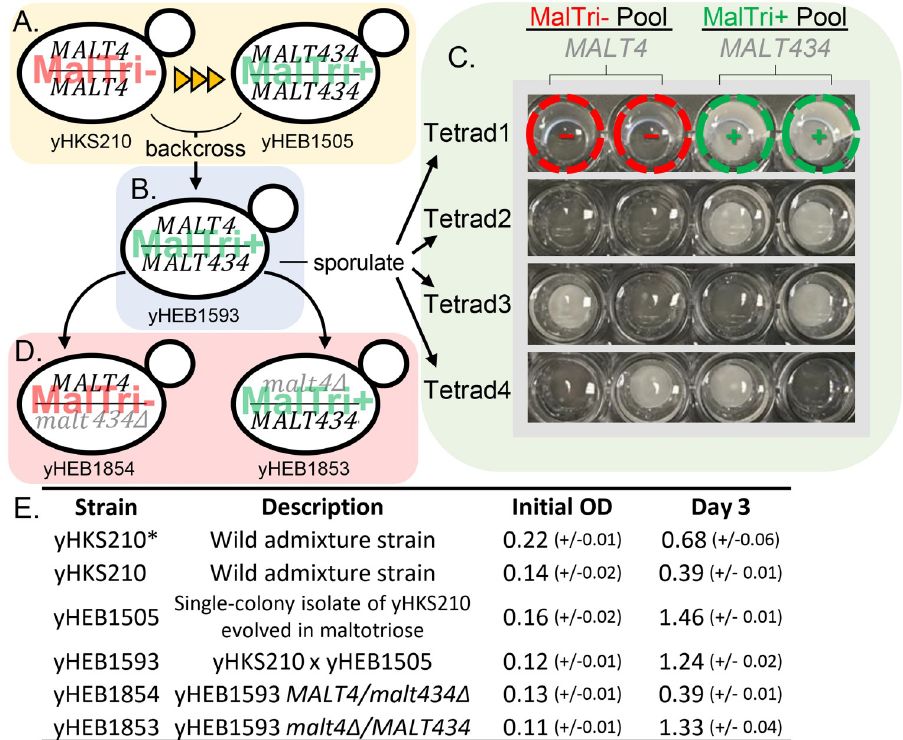
Fig 3. Evolution and validation of the chimeric maltotriose transporter Malt434. A) After continuous culturing on maltotriose with a small amount of added glucose, WI- Seub (yHKS210), which was originally unable to use maltotriose (MalTri-), evolved the ability to consume maltotriose (MalTri+). B) Strain yHEB1593, which is a backcross between yHKS210 and yHEB1505, was also MalTri+. C) To test the inheritance of maltotriose utilization, yHEB1593 was sporulated. The panel shows a subset of tetrads screened growing on SC + 2% maltotriose. Examples of MalTri- spores in Tetrad 1 are circled in red, and MalTri+ examples are circled in green. Whole genome sequencing of MalTri+ and MalTri- pools showed that maltotriose utilization perfectly correlated with the presence/absence of MALT434 . D) Reciprocal hemizygosity test [81] of the MALT4/MALT434 locus in the backcross strain yHEB1593. E) Table of initial and day-three OD 600 (OD) readings of yHKS210, yHEB1505, yHEB1593, yHEB1853, and yHEB1854 on SC + 2% maltotriose as the sole carbon source. N = 3, standard deviation in parentheses. � Control grown in SC + 0.04% glucose to reflect the approximate amount of growth expected from contamination with other carbon sources when using 98% pure